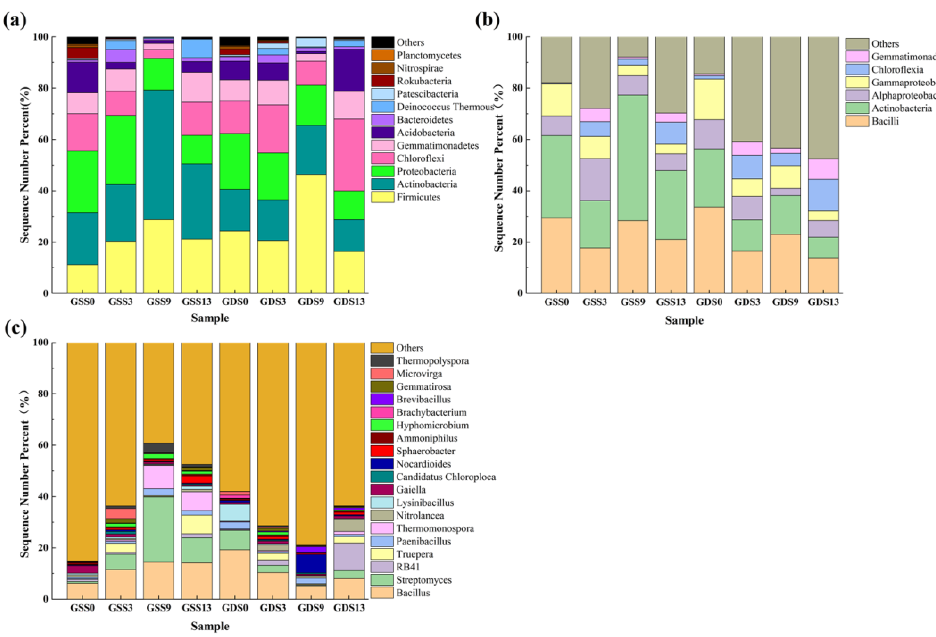
Figure 1. Dominant bacteria in soil microbial communities at the phylum ( a ); class ( b ); genus ( c ) levels at different years of cultivation.